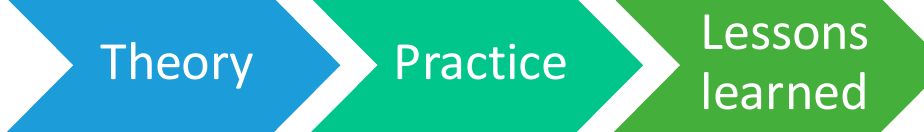
Figure 1. The paper starts with theory in Sections 3 and 4, describes recycling in practice in Section 5 and lessons learned are identified in Section 6.